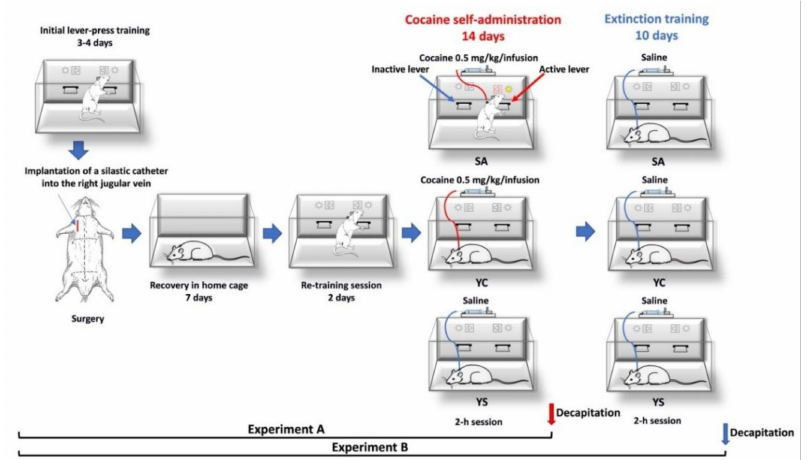
Figure 2. Graphical diagram illustrating the successive steps of the experimental procedure. SA— cocaine self-administration, YC—yoked cocaine administration, YS—yoked saline